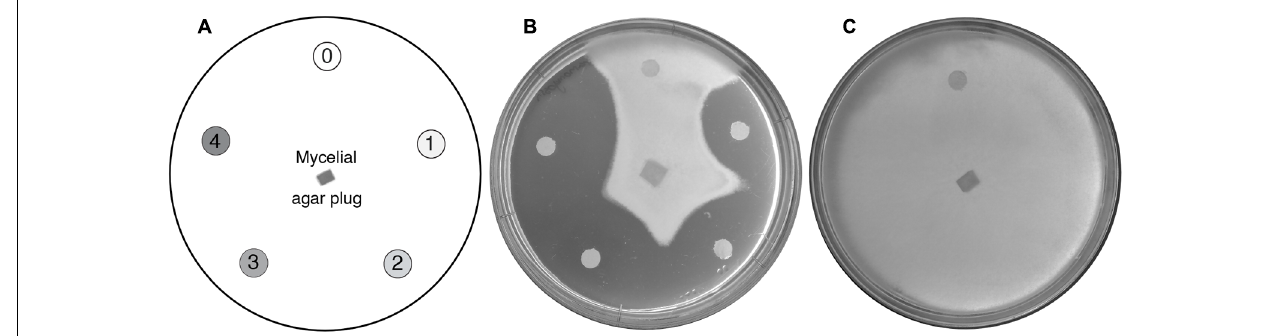
FIGURE 1 | High-throughput screening for anti-oomycete compounds. (A) Diagram showing the standard test arrangement. An agar plug of mycelium is used to inoculate an agar plate with disks saturated either with water (control; marked 0) or increasing concentrations of a test compound (in a clockwise direction, marked 1–4). (B) Representative results from a typical experiment. Here, P. agathidicida mycelial growth is inhibited in the presence of increasing concentrations of paromomycin. (C) Control plate showing normal growth of P. agathidicida in the absence of test compounds.